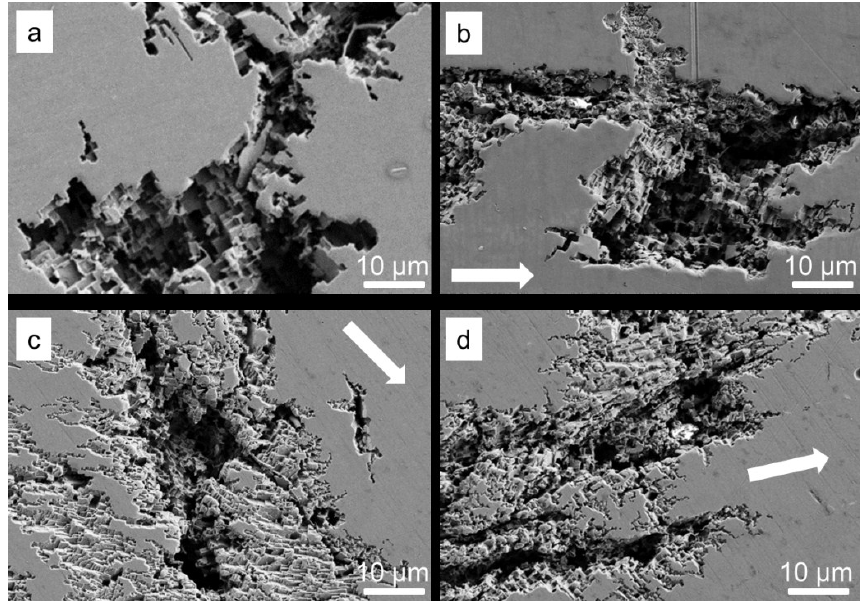
Figure 7. Formation of crystallographic {100} facetted pits due to micro-scale potentiodynamic polarization in the ( a ) cast condition; ( b ) in the extruded condition (extrusion direction and grain alignment marked by arrow); ( c ) in ECAP condition in the matrix and ( d ) in a shear band (deformation direction marked by